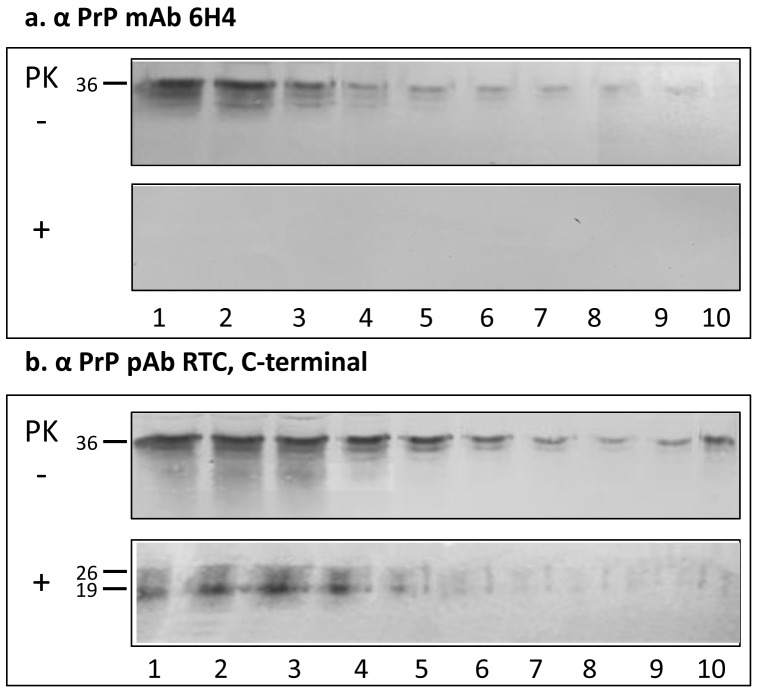
PK-resistant PrP in light fractions of TgMHu2ME199K brain gradients.Sarkosyl extracted brain homogenates of sick TgMHu2ME199K/wt mice (in the figure: 9 month old score = 4) were subjected to ultracentrifugation in 10–60% sucrose gradients. Individual fractions were digested in the presence or absence of PK and immunoblotted with: (a) α-PrP mAb 6H4 and (b) α-PrP pAb RTC directed against the C-terminal end of PrP.